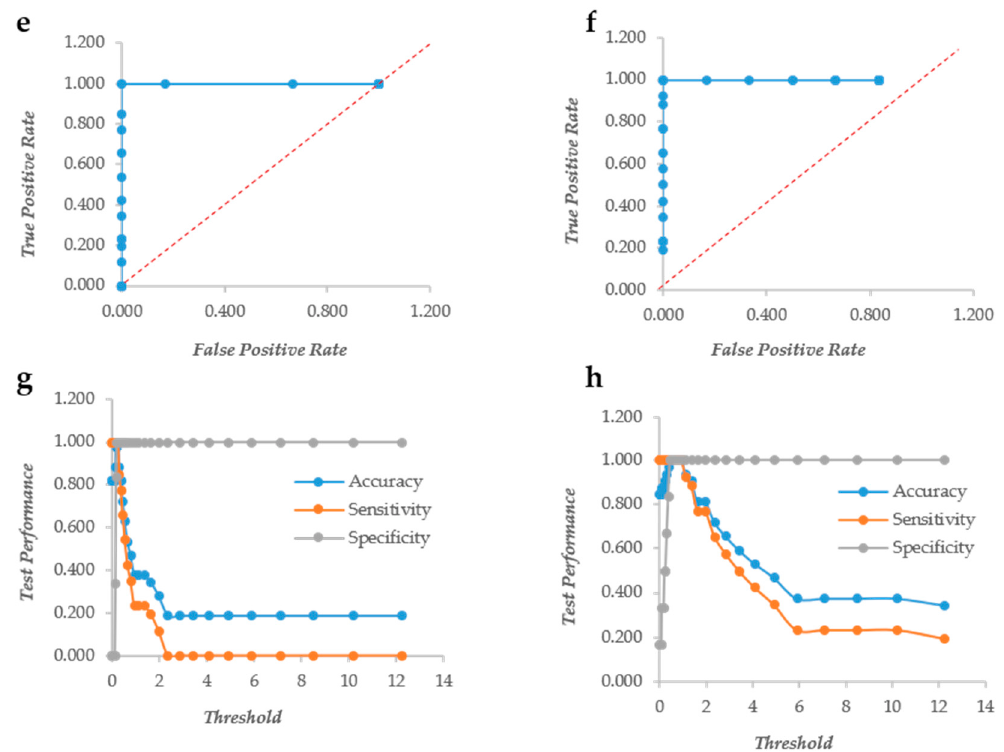
Figure 2. The Response Operator Characteristic (ROC) curves showing the ability to classify raw and normalized CV and XTT TECAN reads of Staphylococcus aureus biofilm. The ROC curve and its parameters were obtained from raw read values recorded for CV staining (Panel ( a ) and ( c ) respectively), from normalized read values calculated for CV staining (Panel ( b ) and ( d ) respectively), from raw read values recorded for XTT staining (Panel ( e ) and ( g ) respectively) and from normalized read values calculated for XTT staining (Panel ( f ) and ( h ) respectively).